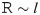
Distribution of epistasis values as a function of the distance, R, between mutations in the reference fold in S1 Fig.Data points satisfy the condition defined in Fig 1. Peaks in the density of points at R∼l, etc. reflect typical distances between pairs of monomers in the reference fold.